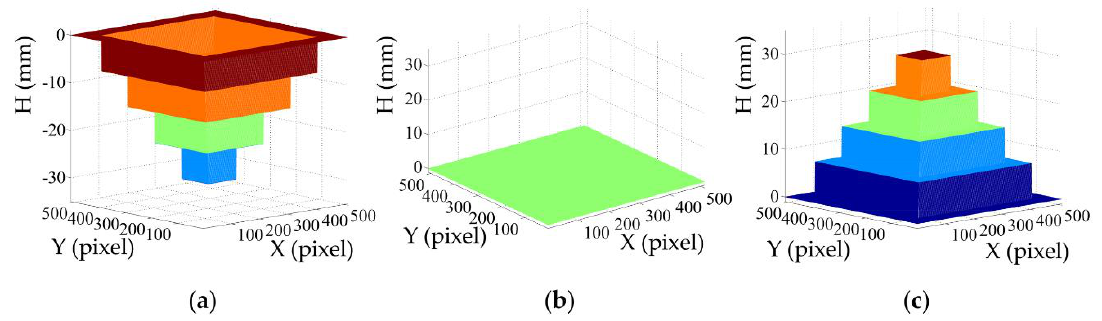
Figure 6. Simulated dynamic stepped model at different moments ( a ) t = 50 ( b ) t = 100 ( c ) t = 150.